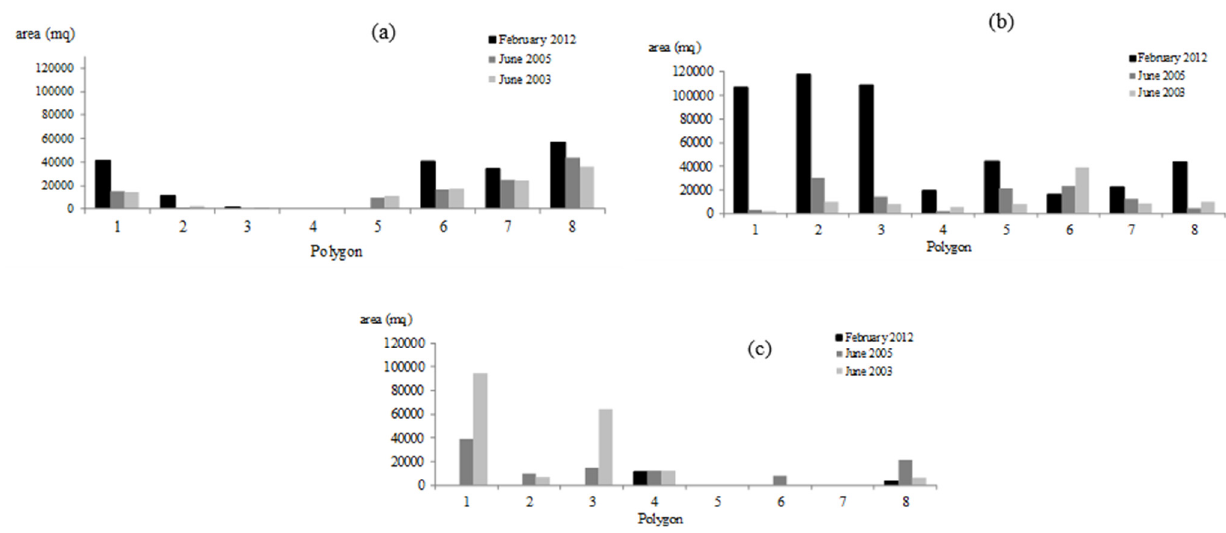
Figure 5. Area extension of the vegetation islands: ( a ) Class A; ( b ) Class B; ( c ) Class C.